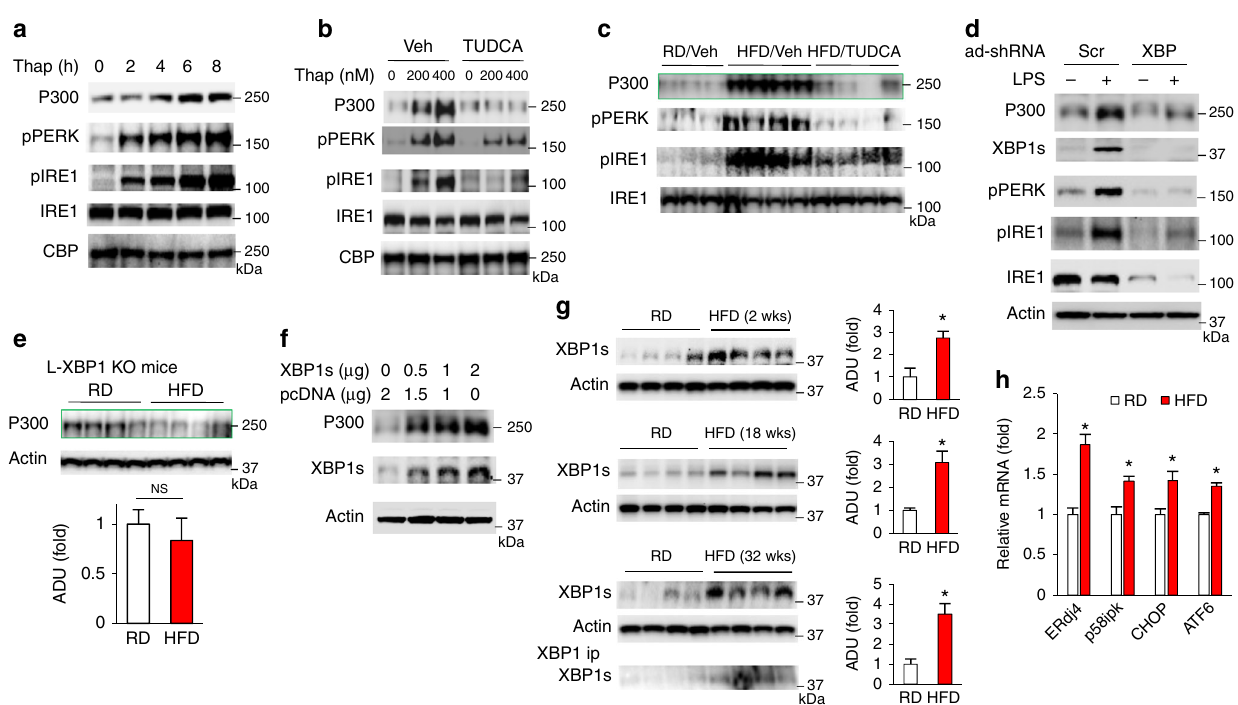
Fig. 3 Activation of the IRE1-XBP1s pathway leads to P300 induction and cytoplasmic distribution. a Hepa1-6 cells were treated with 300 nM thapsigargin and harvested at indicated time points. b Hepa1-6 cells were pretreated with TUDCA (500 μ g ml − 1 ) for 1 h, then, treated with indicated amounts of thapsigargin for 4 h. c Mice were fed an HFD along with the treatment of TUDCA (500 mg kg − 1 d − 1 i.p.) for 2 weeks. RD, regular diet. Veh, vehicle. d Immunoblots of lysates from Hepa1-6 cells treated with SCR or XBP1 adenoviral shRNAs for 24 h followed by treatment with LPS for 24 h. e Homozygous fl oxed XBP1 mice were injected with AAV8-TBG-Cre (1 × 10 11 GC/mouse) through the jugular vein, and fed on an HFD for 2 weeks. ( lower ) Densitometric analysis of P300 in the liver. f Hepa1-6 cells were transfected with equal amounts of expression plasmids of pcDNA and XBP1s for 48 h. g Activation of ER stress in the liver of age-matched male mice fed an HFD for 2 – 32 weeks. Right panel, densitometric analysis of XBP1s in the liver ( n = 4). h The mRNA levels of ERdj4, p58 ipk , CHOP, and ATF6 in the liver of age-matched mice fed a regular diet or HFD (18 weeks). Each bar represents